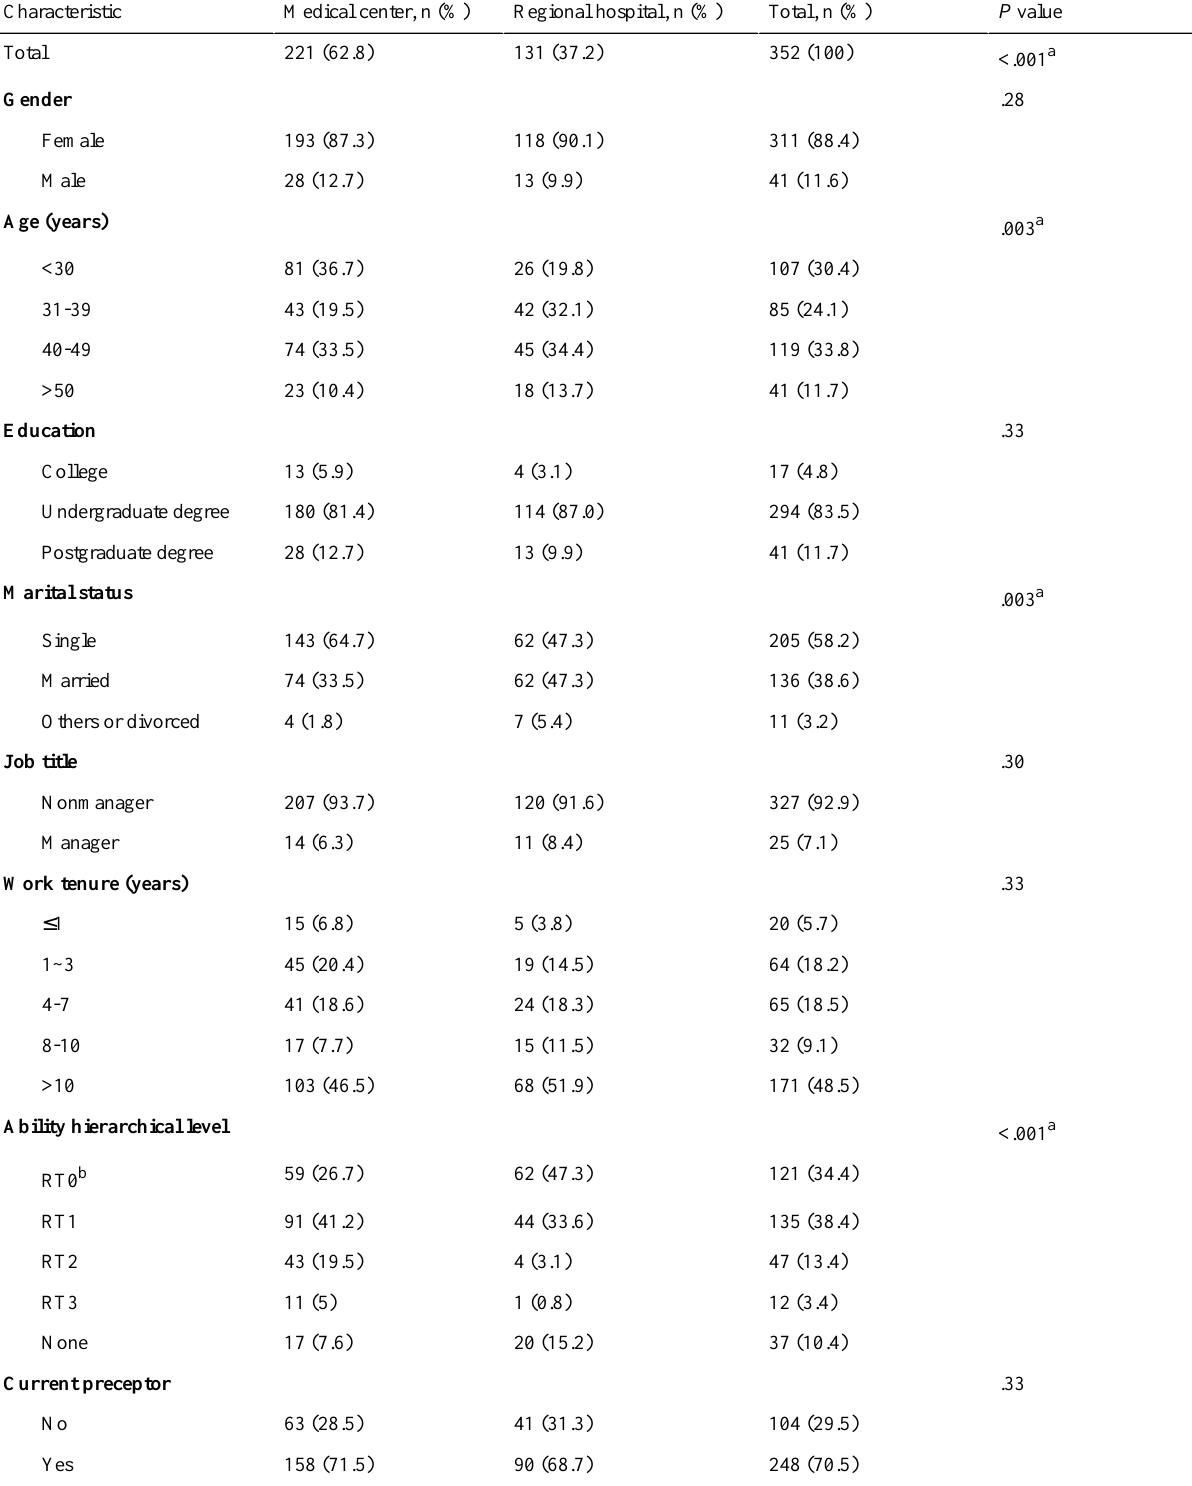
Table 1. The demographical characteristics